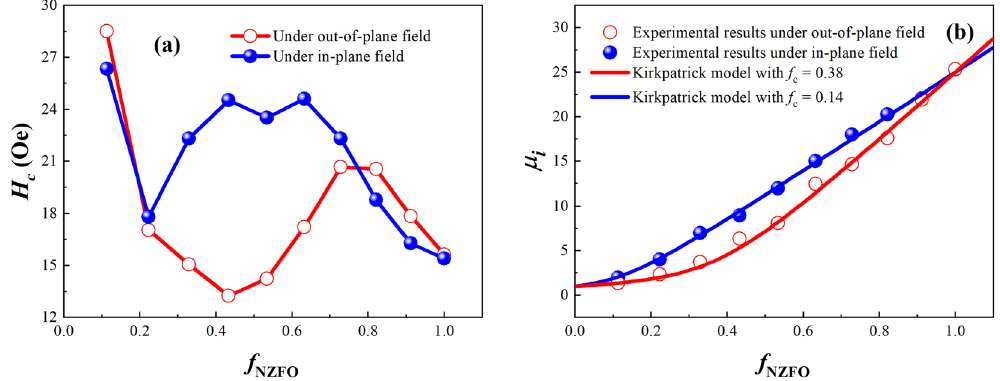
Figure 3. ( a ) Coercivity and ( b ) initial permeability of the BTO-NZFO composite thin films under out-of- plane and in-plane electric fields as a function of f NZFO